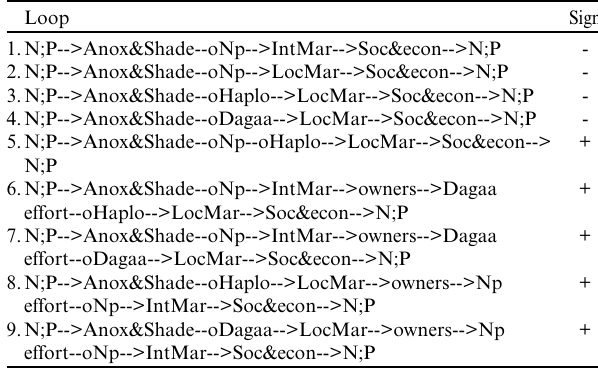
Table 2 . Eutrophication loops and their signs. N;P = nitrogen and phosphorus; Anox&Shade = anoxia and shading; Np = Nile perch; IntMar = international market; Soc&econ = society and economy; LocMar = local and regional market; Haplo = haplochromines; Dagaa = Rastrineobola argentea ; --> = positive interaction; --o = negative interaction.